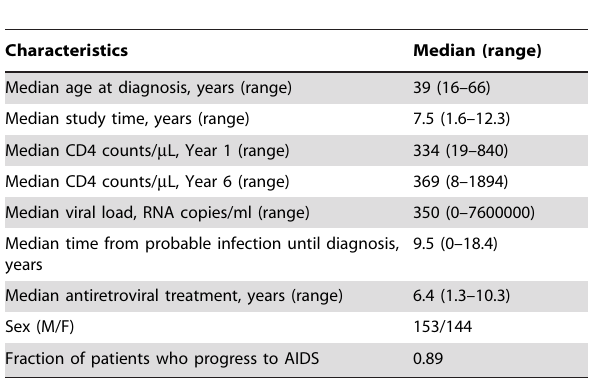
Table 2. Distribution of candidate SNPs in studied subjects